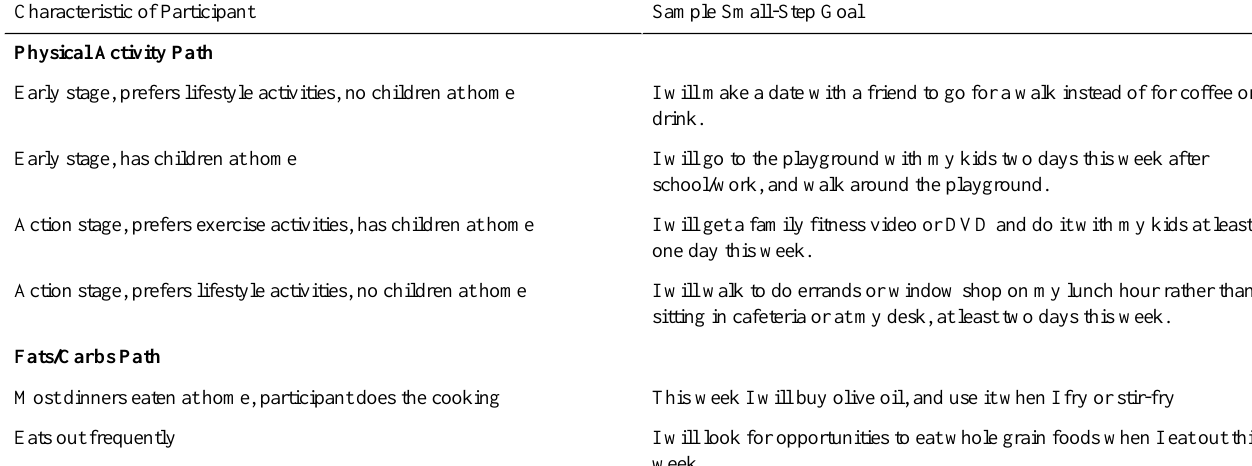
Sample Small-Step GoalCharacteristic of